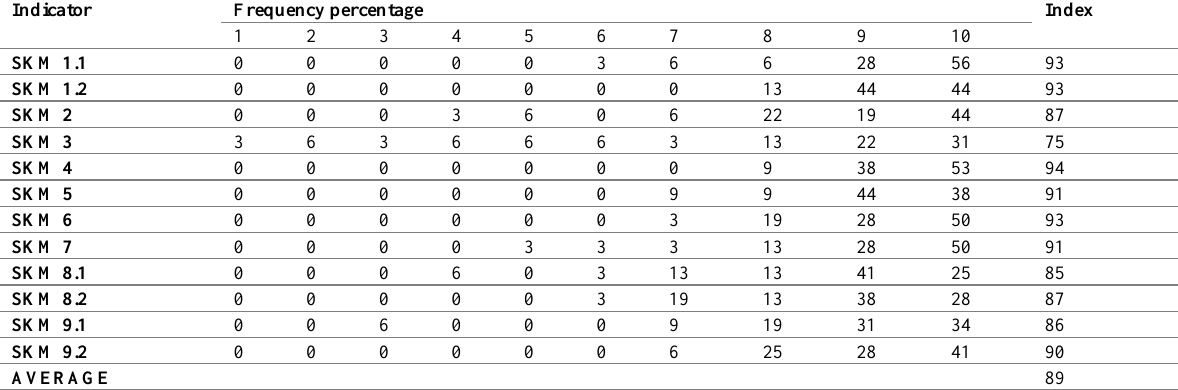
Table 5: Percentage of Frequency of Respondents' Answers and Average Variable Index Value Indicator